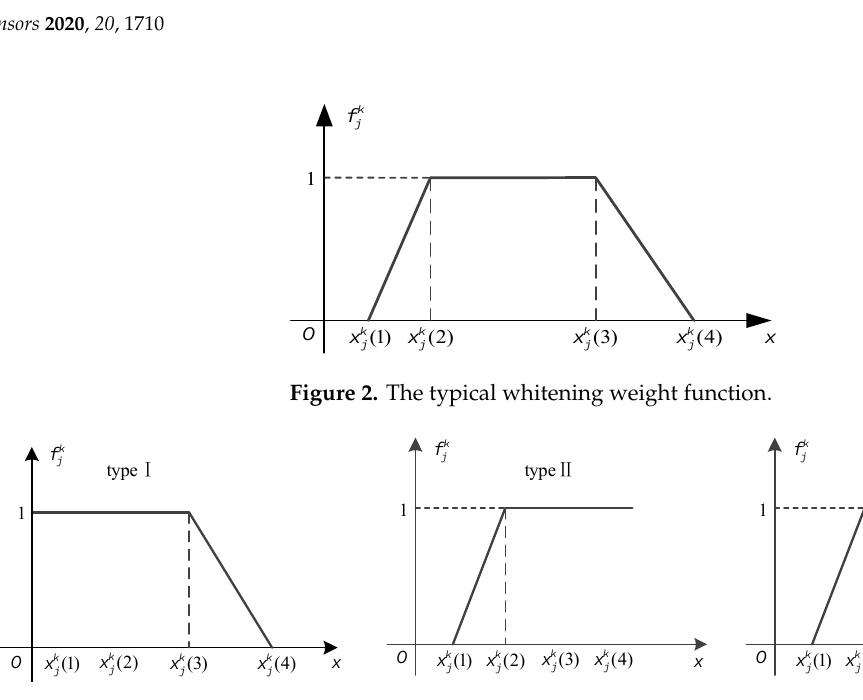
Figure 3. The whitening weight function types.